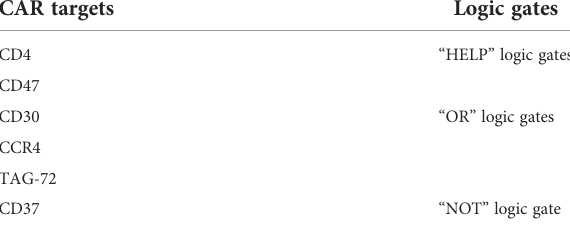
TABLE 1 Potential CAR targets and their respective logic gate strategies to enhance the recognition and precision of CAR-T therapy in CTCL treatment.